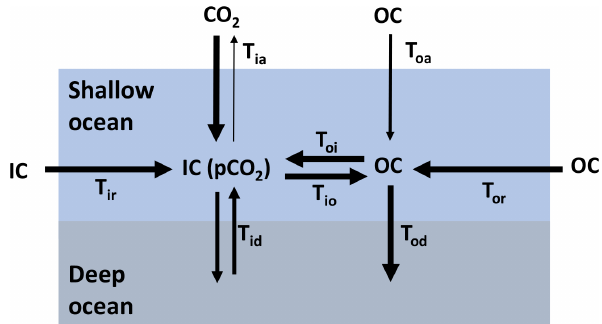
Figure 2. Illustration of the key carbon fluxes from the atmosphere to the deep oceans, with subscripts “i” and “o”; referring to inor- ganic and organic forms of carbon, respectively. T ia and T oa are ex- changes with the atmosphere, T ir and T or are river transport, T io and T oi are the inter-conversions between organic and inorganic forms in the ocean, and T id and T od are the transfers from shallow to deep